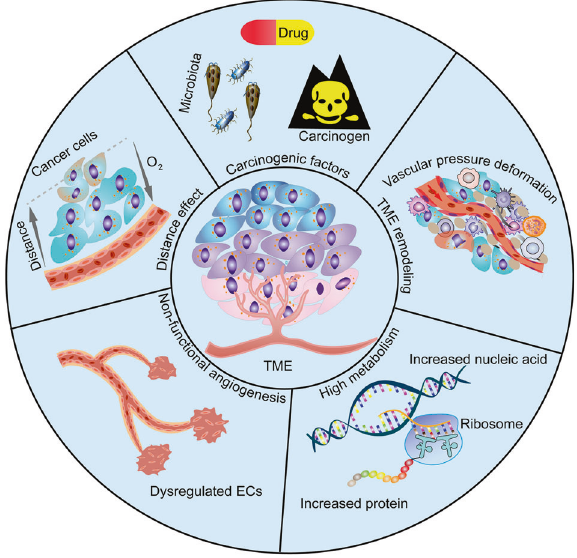
Fig. 2 Potential factors contributing to tumor hypoxia. Carcinogenic factors, such as drug, carcinogen, and microbiota dysbiosis, impair EC shape and function in the vascular system. TME is remodeled by tumor cells, stromal cells and stromal components (e.g., fi brin), resulting in vascular deformation due to pressure. High metabolism in cancer cells, such as increased nucleic acid synthesis and increased protein anabolism, leads to relative hypoxia. Dysregulated proliferation and alignment of vascular ECs result in the formation of non-functional blood vessels. With the increased distance between tumor cells and blood vessels, O 2 diffusion decreases and leads to hypoxia FACTORS CONTRIBUTING TO HYPOXIA IN CANCER The vasculature ensures the presence of tissue oxygen and energy substances. Vasculature endothelial cells (ECs) of cancer tissues or pre-neoplastic tissues are exposed to harmful substances,